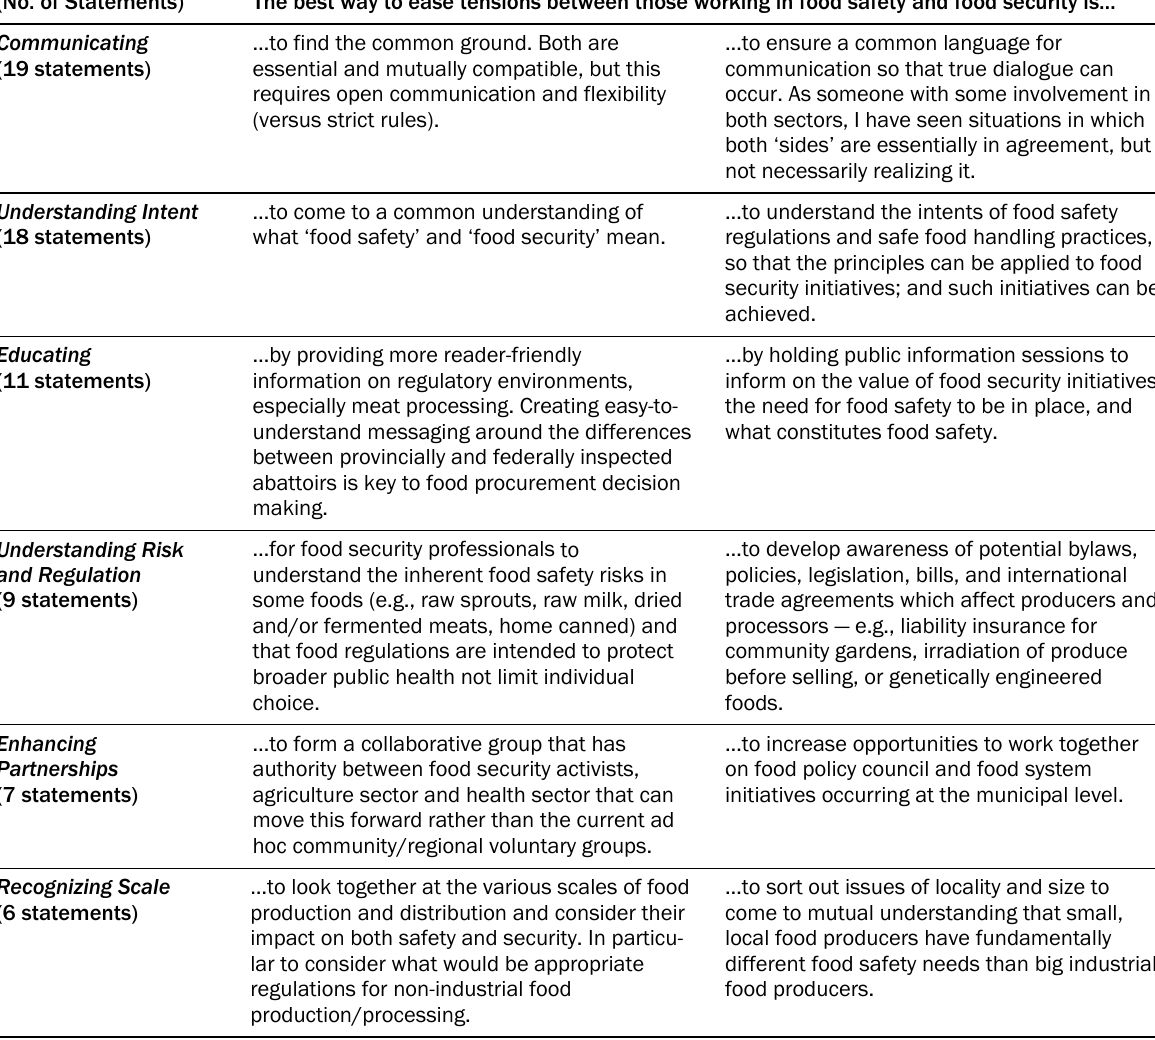
Table 2. Highly Rated Statements by